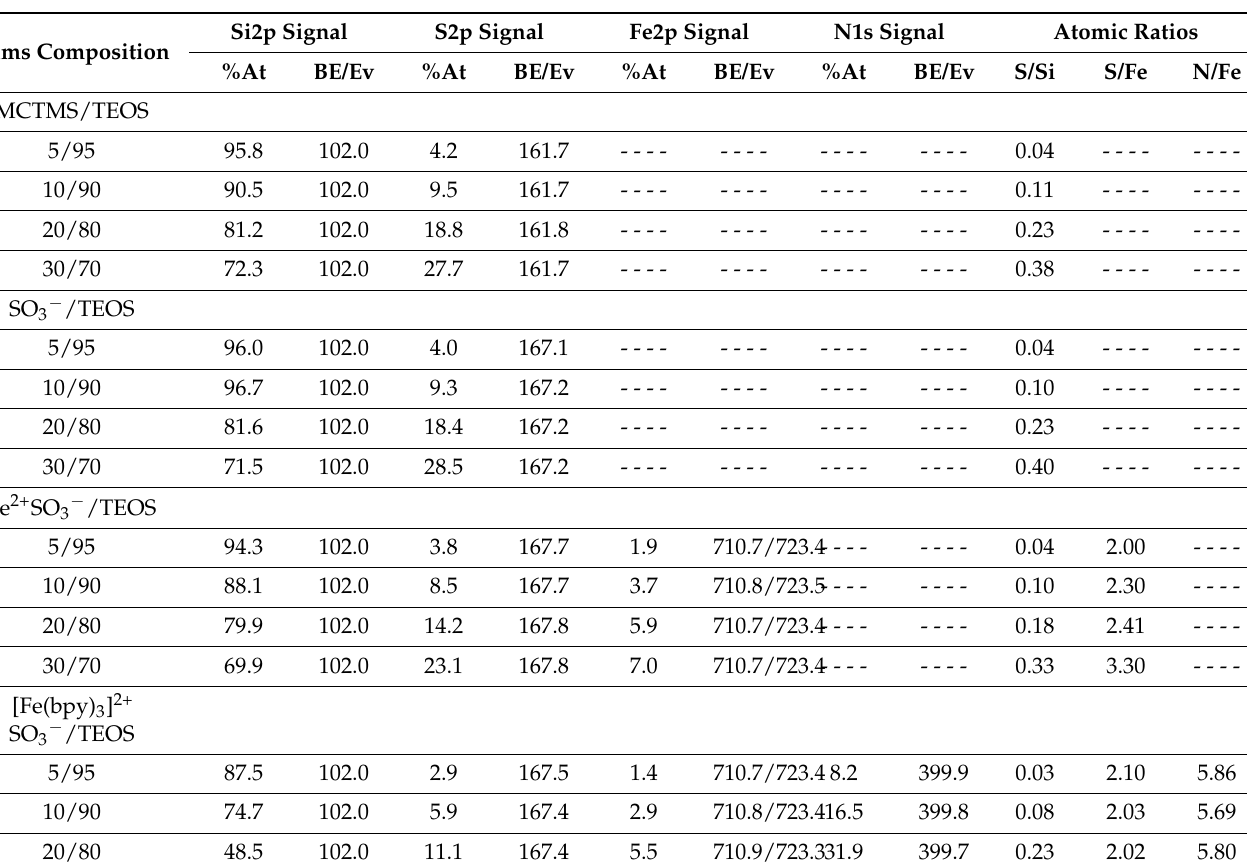
Table 1. Atomic composition (% At.) and binding energies (BE) for the functionalized mesoporous silica films at each step of the modification process (data obtained from the XPS